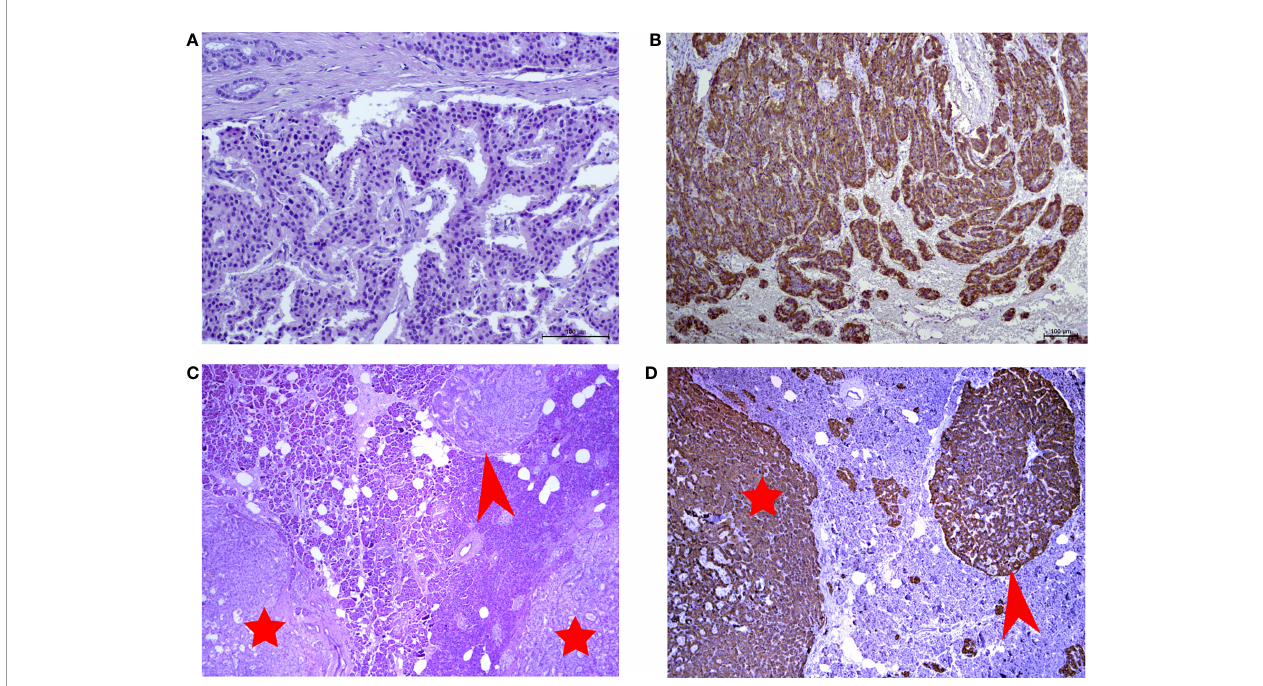
FIGURE 1 | (A) Hematoxylin and eosin (H&E)-stained slide of insulinoma (x250 magni fi cation). (B) Immunohistochemical reaction with antibodies to insulin in insulinoma (x125 magni fi cation). (C) Hematoxylin and eosin (H&E)-stained slide of microtumors (x10 magni fi cation). (D) Immunohistochemical reaction with